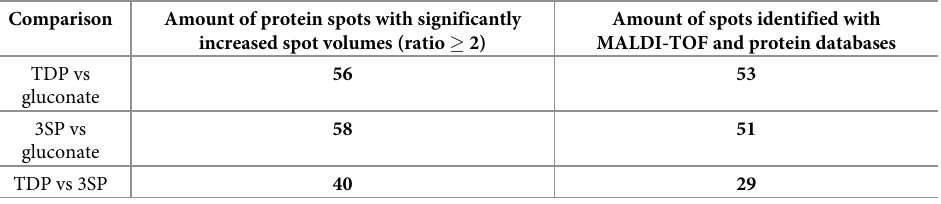
Table 2. Amounts of proteins detected via 2D gel analysis for the different cultivation conditions. Comparison